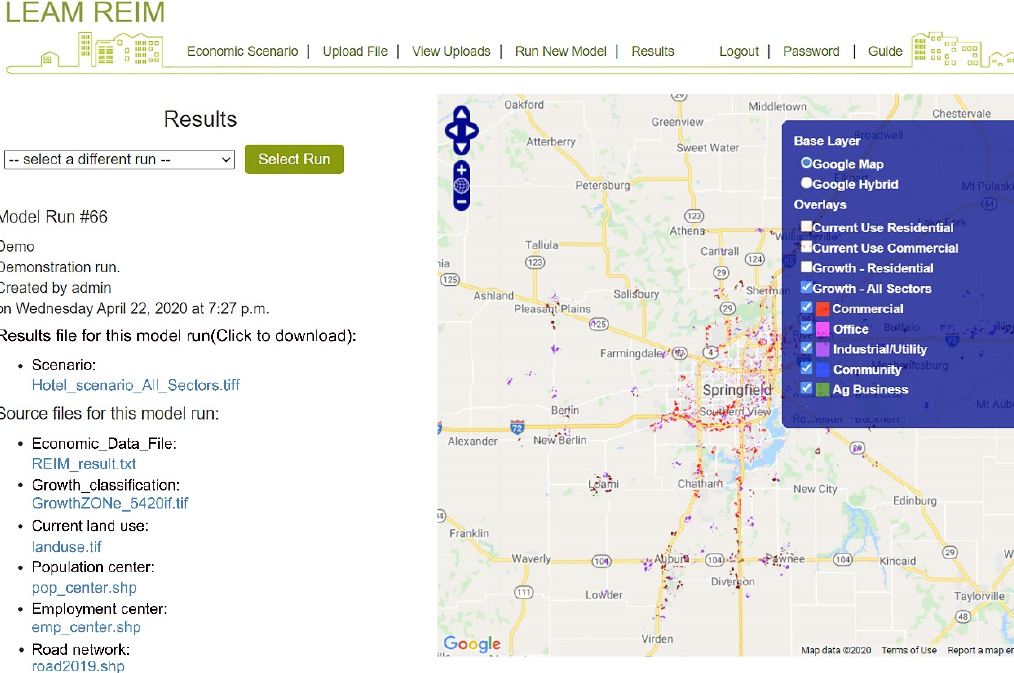
Figure 10. LEAM-REIM interface for visualizing and downloading model scenario result. The map shows the visualized estimated six land-use sector changes (yellow color for residential, red color for commercial, pink color for office, purple color for industrial/utility, blue color for community, and green color for agricultural business). Users are able to show or hide the current and estimated land use layers to compare in the right-top blue box. All previous model results are also available through the “select a different run” drop list.